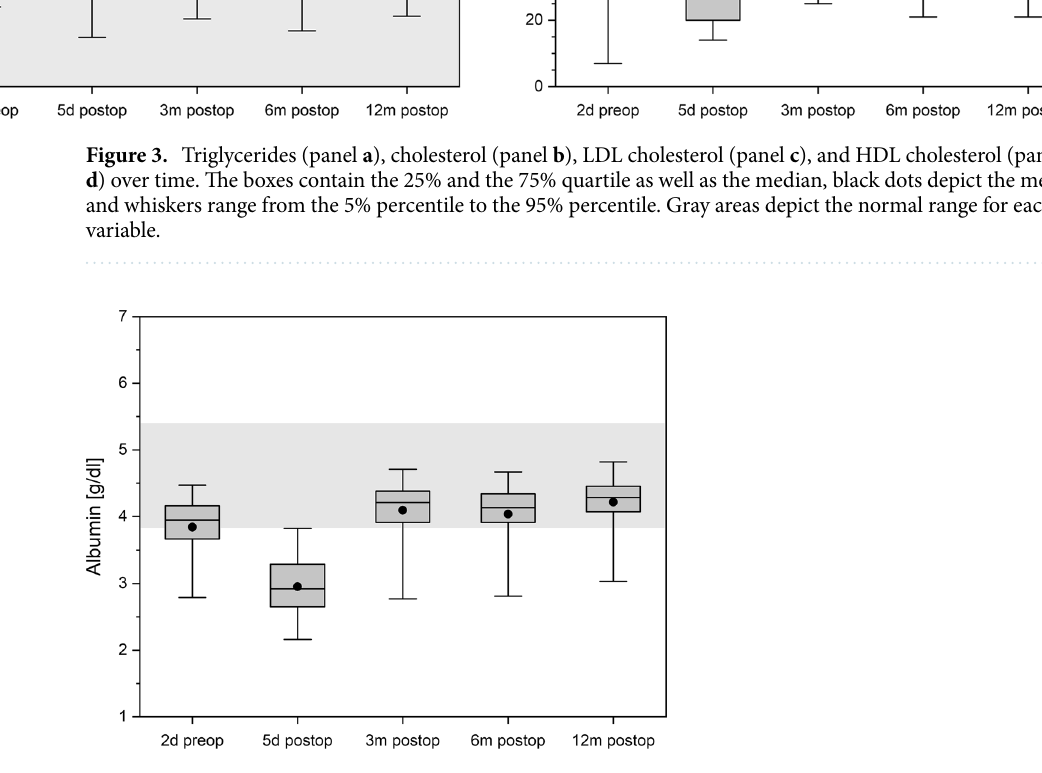
Figure 4. Albumin over time. The boxes contain the 25% and the 75% quartile as well as the median, black dots depict the mean, and whiskers range from the 5% percentile to the 95% percentile. Gray areas depict the normal range for each